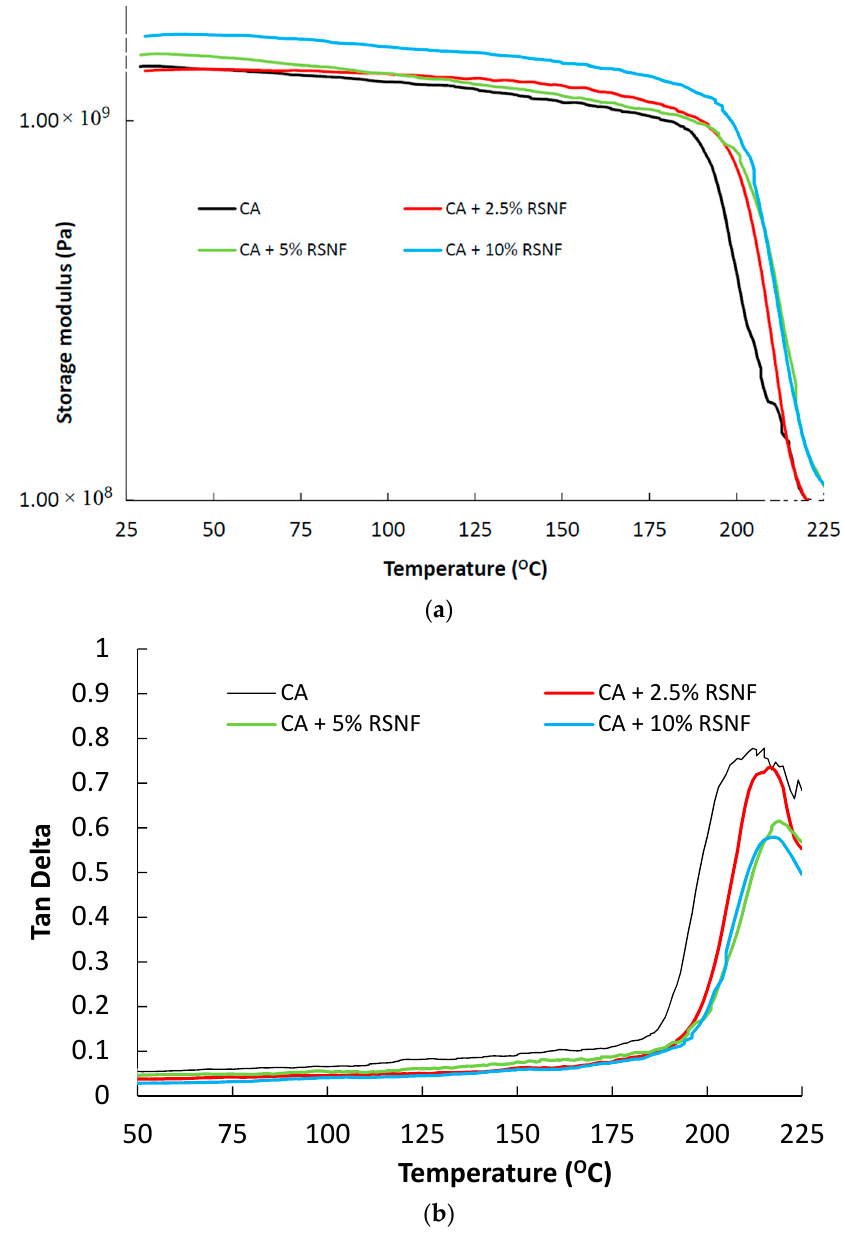
Figure 12. DMTA curves of CA and CA/RSNF films.